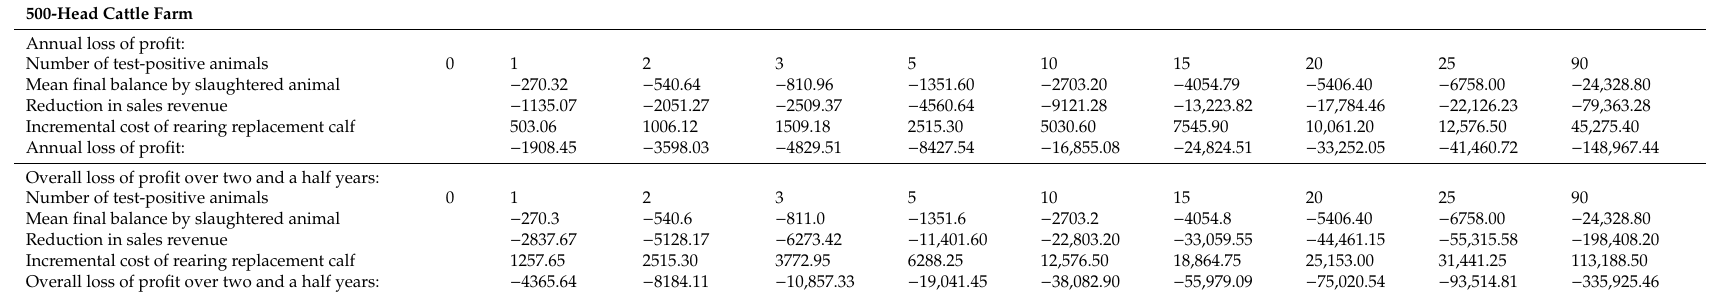
Table 12. Loss of profit on a farm with 500 head of